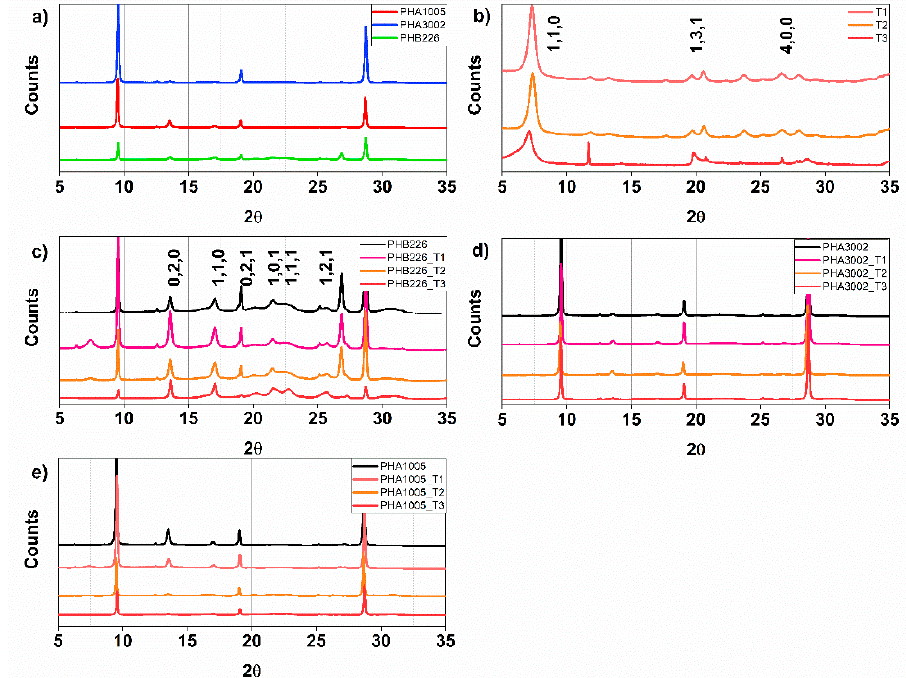
Figure 3. X-Ray di ff raction patterns. ( a ) Raw matrixes: PHA1005, PHA3002 and PHB226; ( b ) Nanoclays: Figure 3. X-Ray diffraction patterns. ( a ) Raw matrixes: PHA1005, PHA3002 and PHB226; ( b ) T1, T2 and T3; ( c ) Neat PHB226 and loaded with 3 wt.% T1, T2 and T3; ( d ) Neat PHA3002 and loaded Nanoclays: T1, T2 and T3; ( c ) Neat PHB226 and loaded with 3 wt. % T1, T2 and T3; ( d ) Neat PHA3002 with 3 wt.% T1, T2 and T3; ( e ) Neat PHA1005 and loaded with 3 wt.% T1, T2 and and loaded with 3 wt. % T1, T2 and T3; ( e ) Neat PHA1005 and loaded with 3 wt. % T1, T2 and T3.